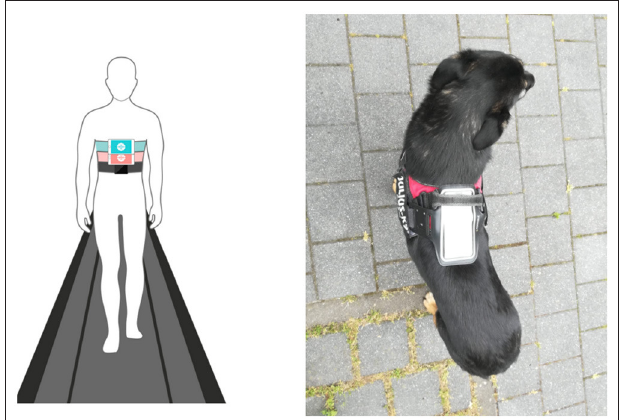
FIGURE 1 | Left: placement of smartphone in Encephalog (Mon4t) iTUG test strapped to the subject’s sternum; Right: placement of smartphone strapped to the dog’s back in our